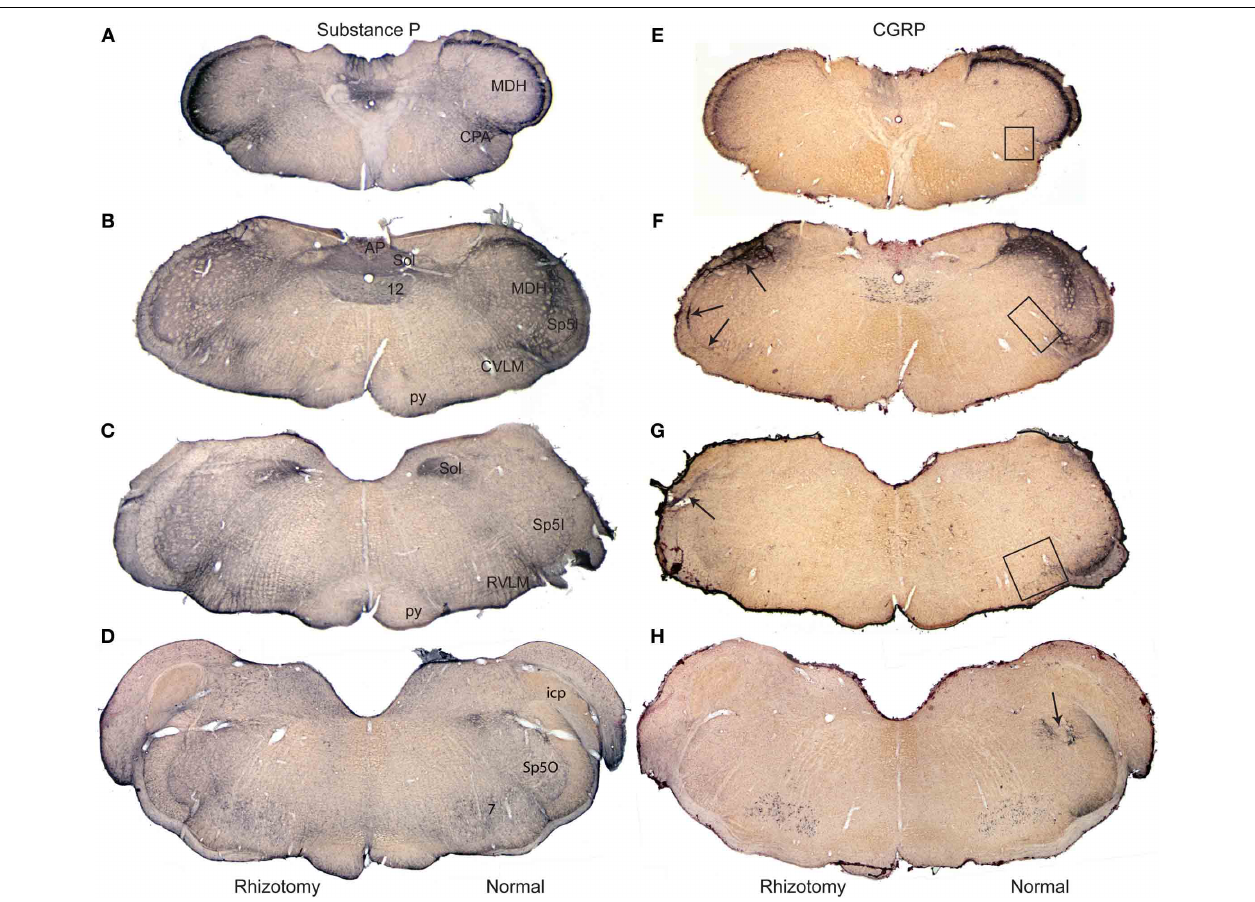
FIGURE 1 | Composite photomicrographs of brainstem sections cut through caudal (A,E), intermediate (B,F,C,G) and rostral (D,H) parts of the medulla comparing the distribution of immunolabel of substance P (A–D) and CGRP (E–H) after a unilateral trigeminal rhizotomy. Immunostaining of Substance P, with numerous central and peripheral sources, was little diminished qualitatively after rhizotomy, but that of CGRP, with fewer central neurons, showed up to a 93% reduction in stained fibers after rhizotomy. Note the band of immunolabel seen in the misplaced substantia gelatinosa between the MDH and subnucleus interpolaris (F) is nearly eliminated after rhizotomy, while that in the CVLM (F) and RVLM (G) is greatly diminished. We have shown previously